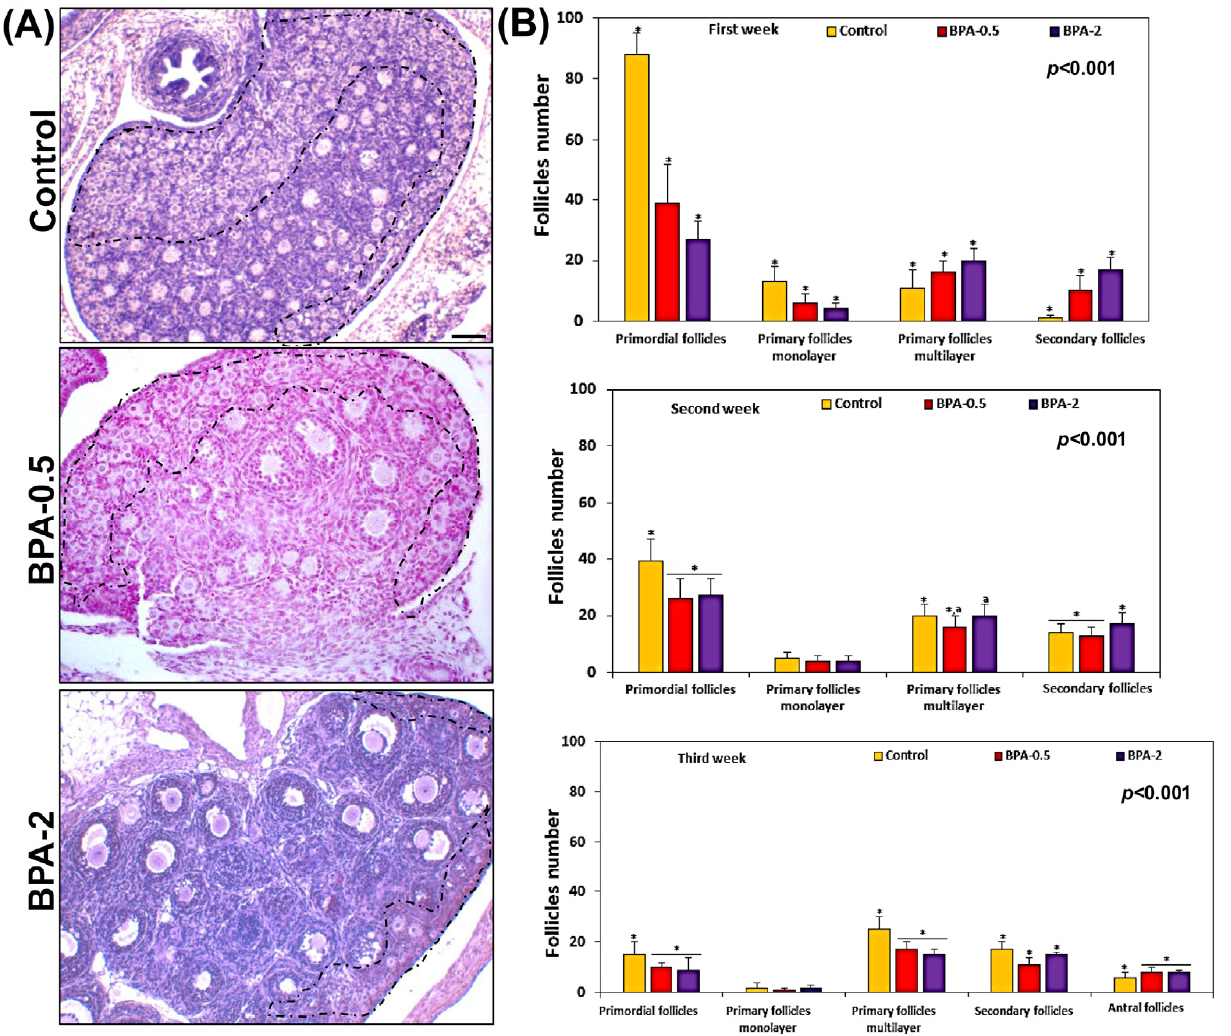
Figure 3. Follicle quantification. Representative images showing the density of follicles in the three experimental groups in the first week of postnatal life. The zone containing the primordial follicles has been roughly marked with the dashed line ( A ); graphs showing the number of each of the different types of ovarian follicles in the three experimental groups in the first three weeks of postnatal life ( B ). Bars represent means ± SD (n = 5). The identical symbol (asterisk) and letter on different bars indicates significant differences between groups. ( A ) Scale bar: 80 µm.